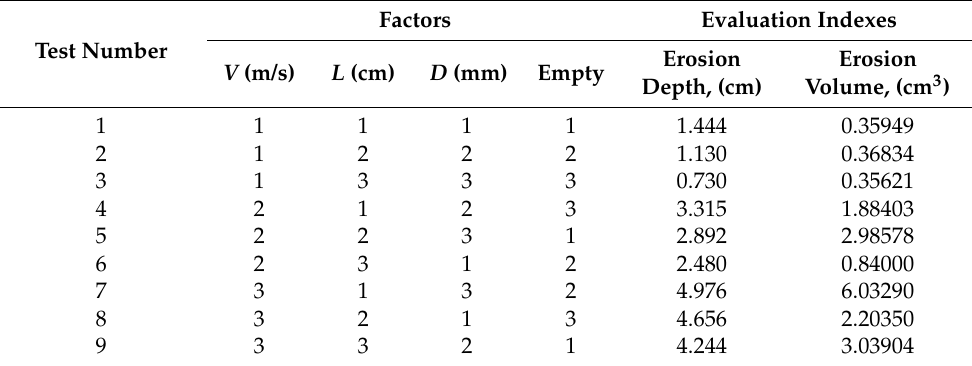
Table 3. Results of the orthogonal